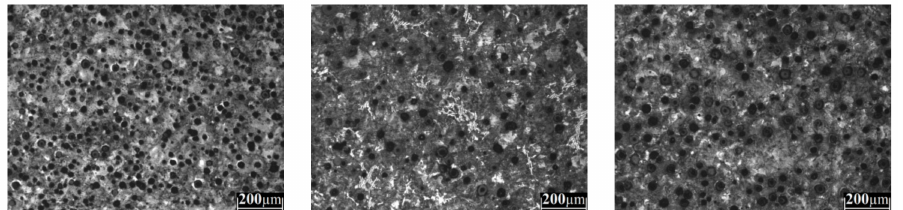
Figure A3. Etched microstructure of the ductile iron alloyed with 0.2 wt % V for different lobes and regions.